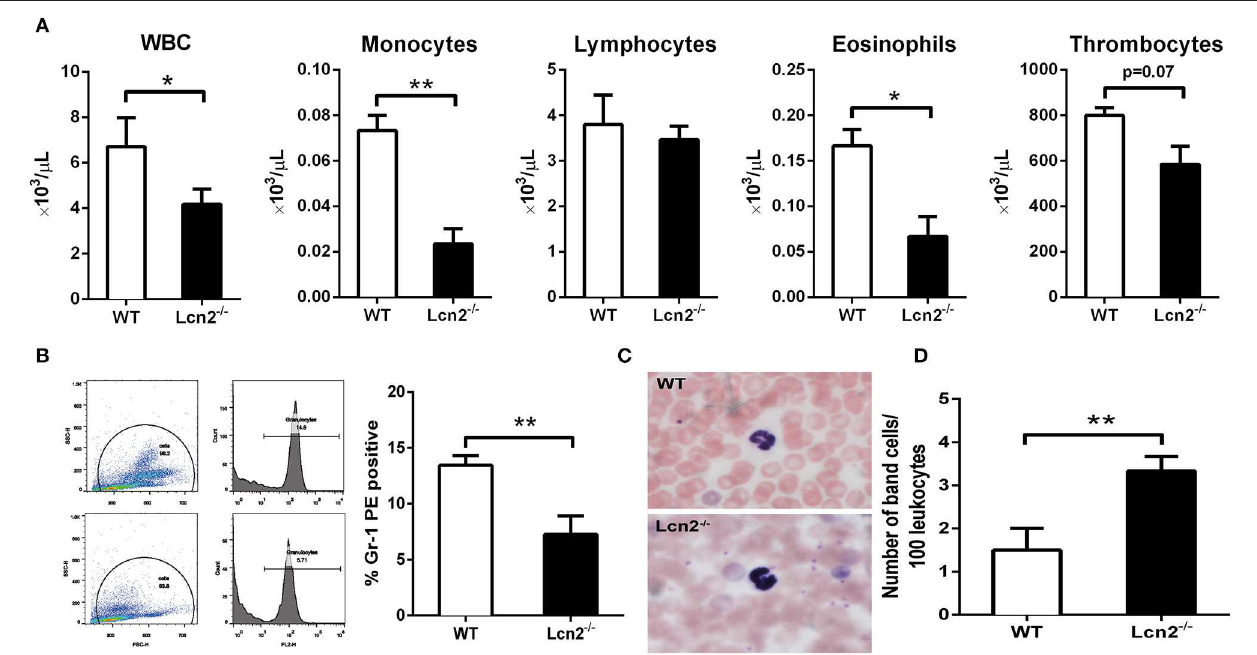
FIGURE 3 | Granulocyte abnormalities in Lcn2 − / − mice. (A) Hematological parameters of peripheral blood from wild-type (WT) and Lcn2 − / − mice. The data are presented as mean × 10 3 cells/ µ l. Error bars depict SEM ( n = 6 per group). (B) Flow cytometry analysis of neutrophils in the peripheral blood after intragastric administration with 2 × 10 8 CFU of E. coli O157:H7. Cells were stained with indicated clones of Gr-1 Ab, and positive cells were determined by flow cytometry. Values are average means of triplicate experiments with two mice per genotype per experiment. Error bars depict SEM. (C) Wright-Giemsa staining of peripheral blood smears from Lcn2 − / − mice identified atypical hyposegmented neutrophils in the peripheral blood. Original magnification × 63. In contrast, WT mice displayed normal neutrophil maturation. (D) Enumeration of the number of band neutrophils in the peripheral blood of Lcn2 − / − mice. The data are presented as mean band cell numbers per 100 leukocytes. Error bars depict SEM. Results are expressed as means ± SEM. P < 0.05 was considered statistically significant. * P < 0.05, and ** P < 0.01.